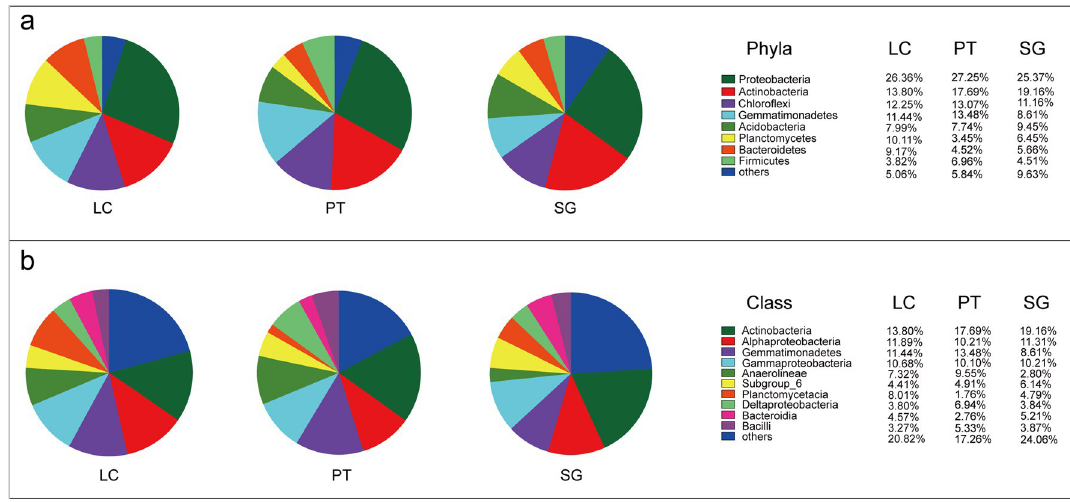
Fig 1. Relative abundance of rhizosphere soil bacterial communities at the phylum level (a) and class level (b) across three halophytes. LC, Leymus chinensis (Trin.) Tzvel.; PT, Puccinellia tenuiflora (Griseb.) Scribn. et Merr.; SG, Suaeda glauca (Bunge) Bunge.